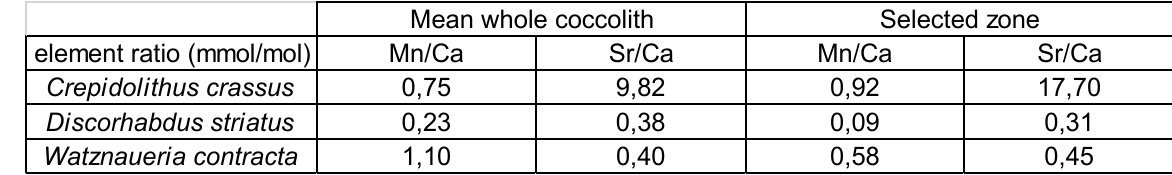
Table 1. Mn/Ca and Sr/Ca (mmol/mol) of whole coccoliths of C. crassus , D. striatus and W. contracta or a selected region (see Supplementary Figure 2), depleted in Mn and